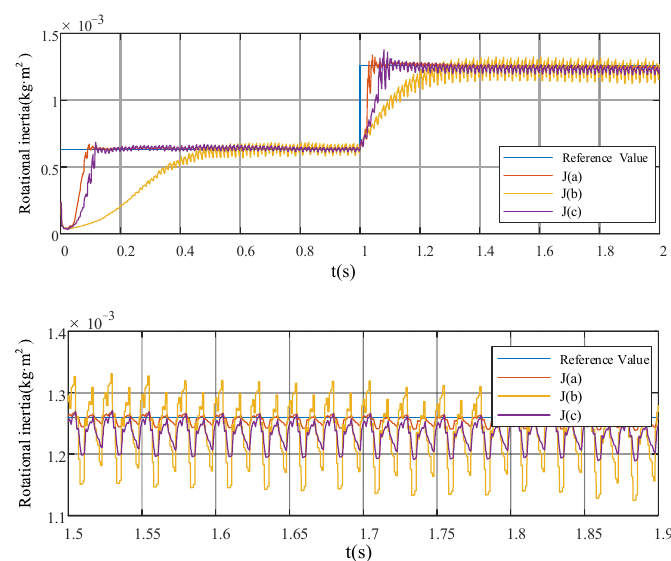
Figure 7. Simulation results of group (a), group (b), and group (c). Table 4. Calculation results of the accuracy parameters.